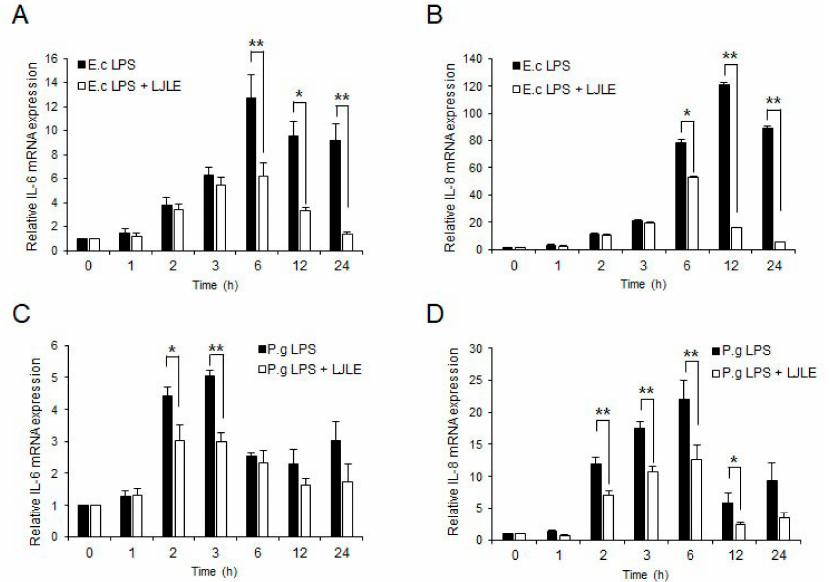
Figure 1. Litsea japonica leaf extract (LJLE) inhibits pro-inflammatory cytokine expression in lipopolysaccharide (LPS)-stimulated human periodontal ligament fibroblasts (PDLFs). Human PDLFs were stimulated with LPS in the absence or presence of 100 μ g/mL LJLE for different times (0, 1, 2, 3, 6, 12, and 24 h). Real-time polymerase chain reaction (PCR) was performed as described in the Materials and Methods. ( A , B ) Time-course effects of LJLE on IL-6 and IL-8 mRNA in 1 ng/mL Escherichia coli (E.c) LPS-stimulated PDLFs. ( C , D ) Time-course effects of LJLE on IL-6 and